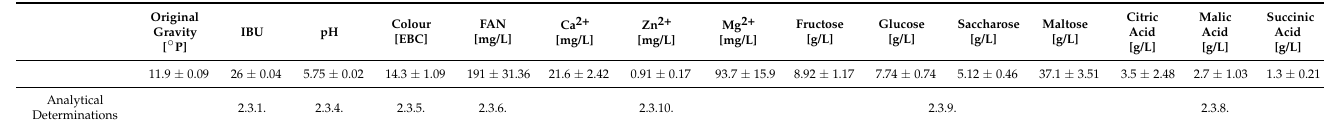
Table 1. The composition of wort before